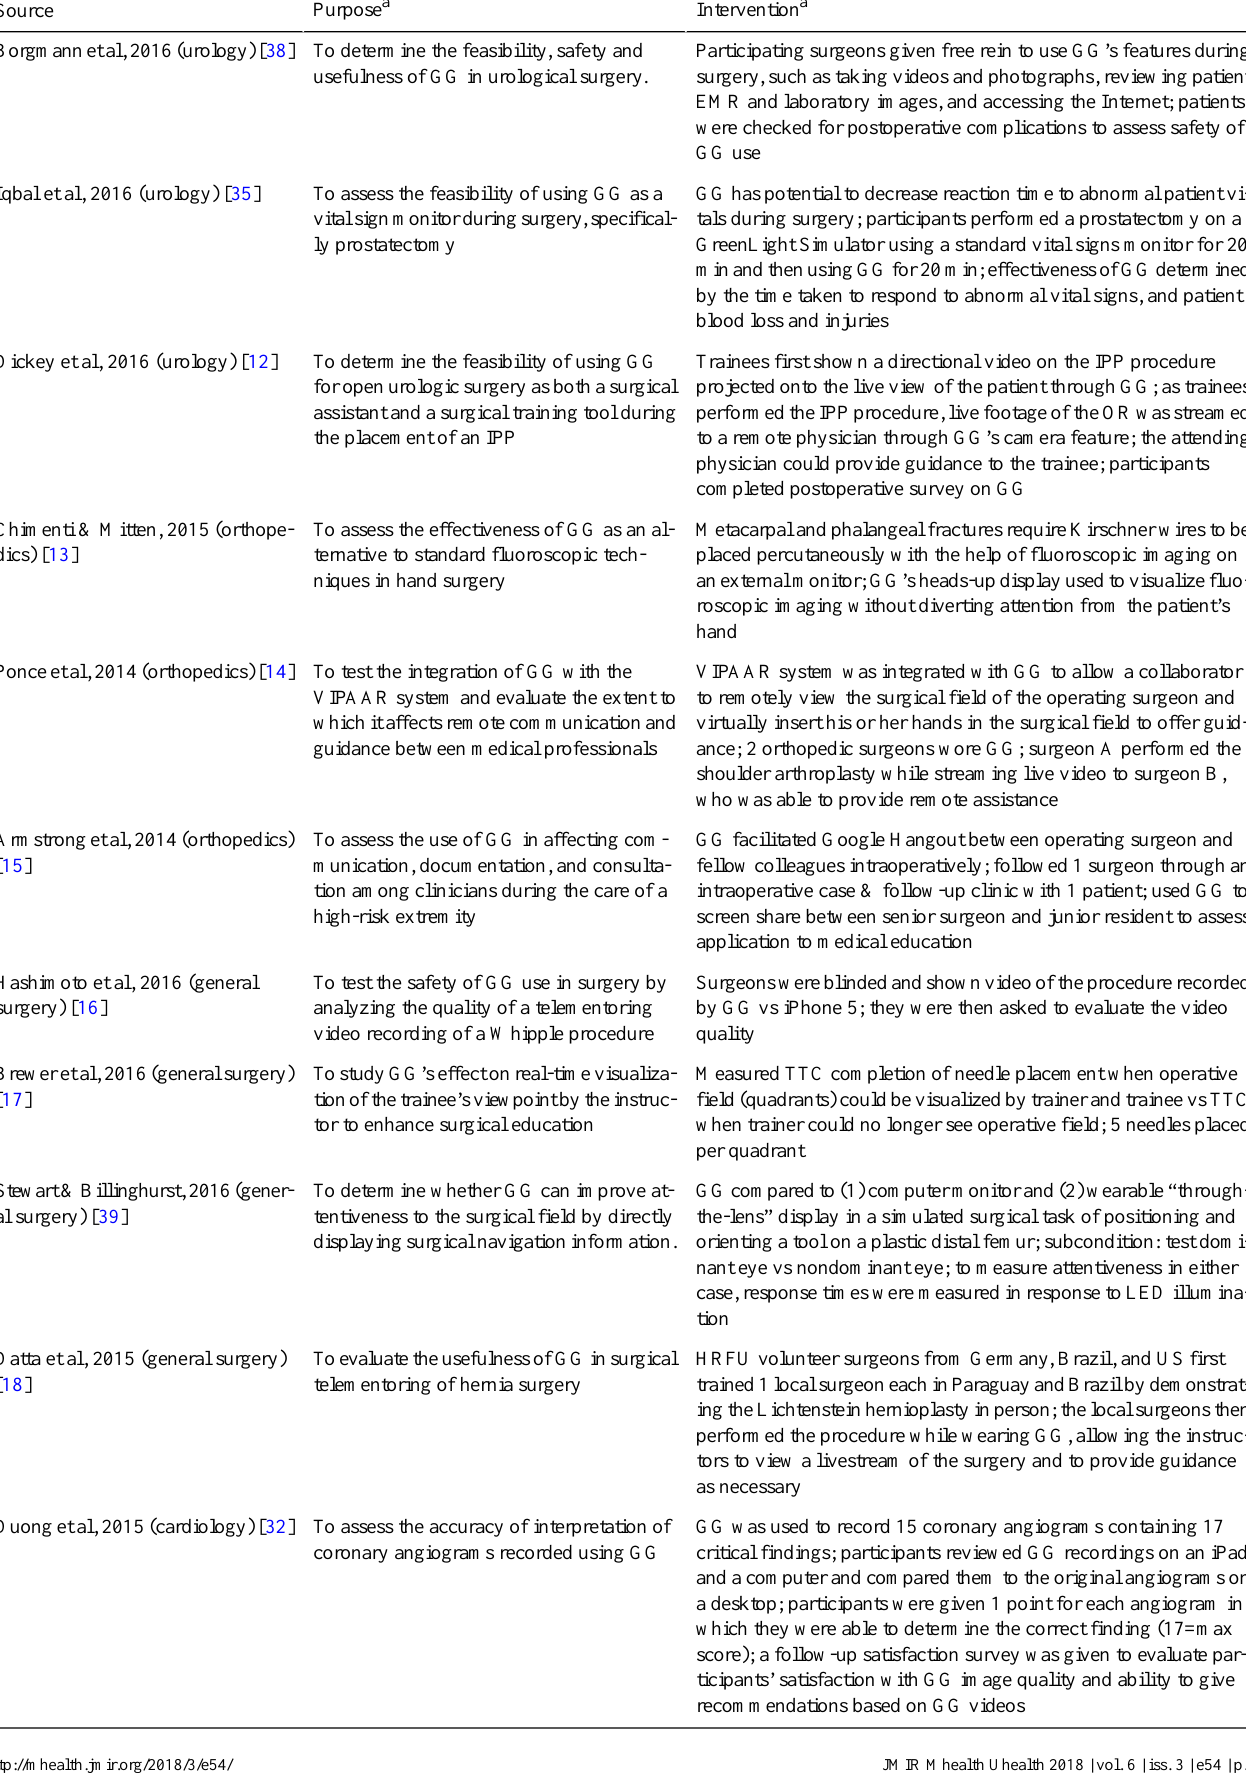
Table 2. Summary of the study purposes and proposed Google Glass intervention